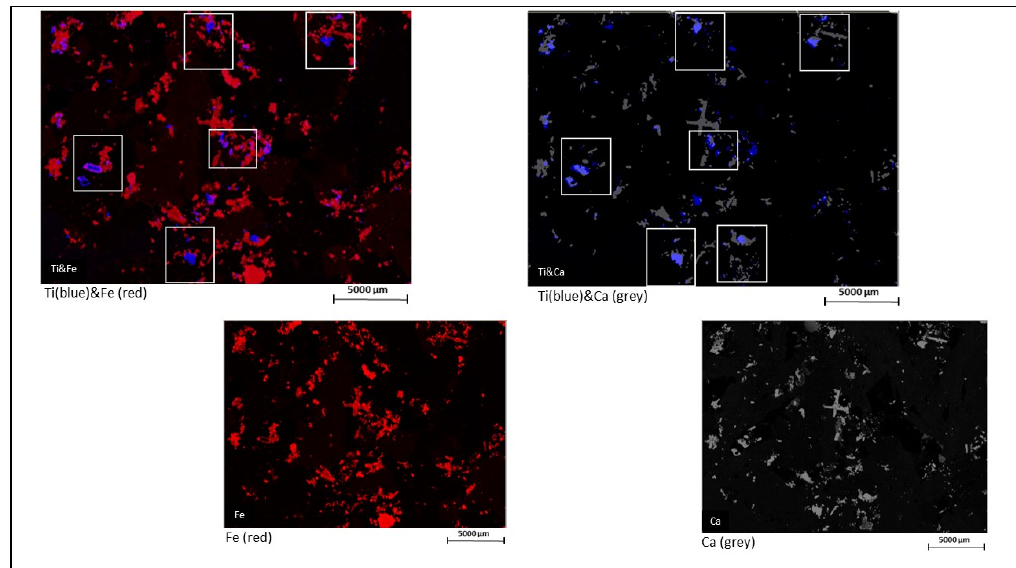
Figure 10. Interpretative overlap of spatial micrometric distribution maps of Ti with Fe and Ca.